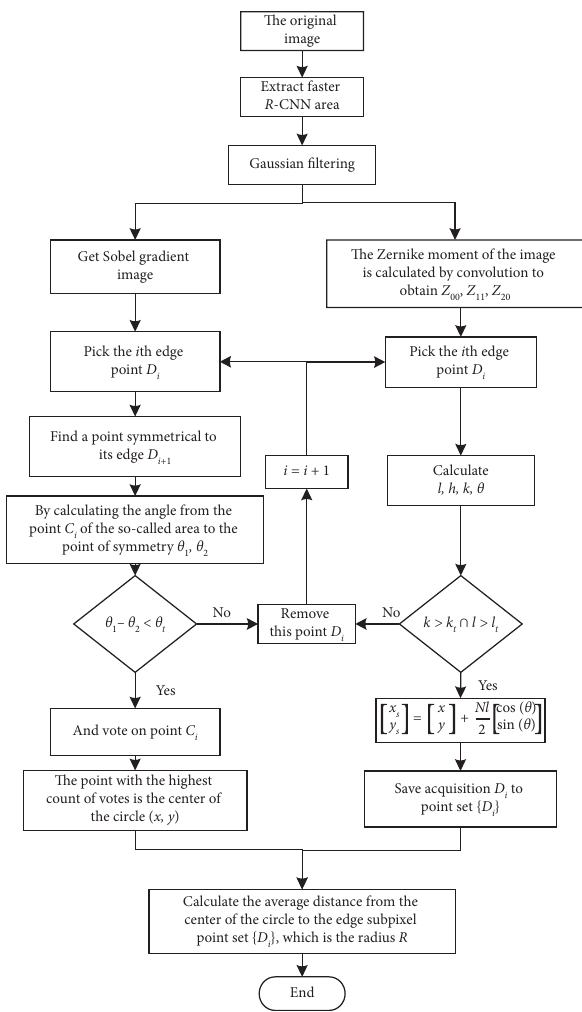
Figure 10: Flowchart of the automobile brake master cylinder